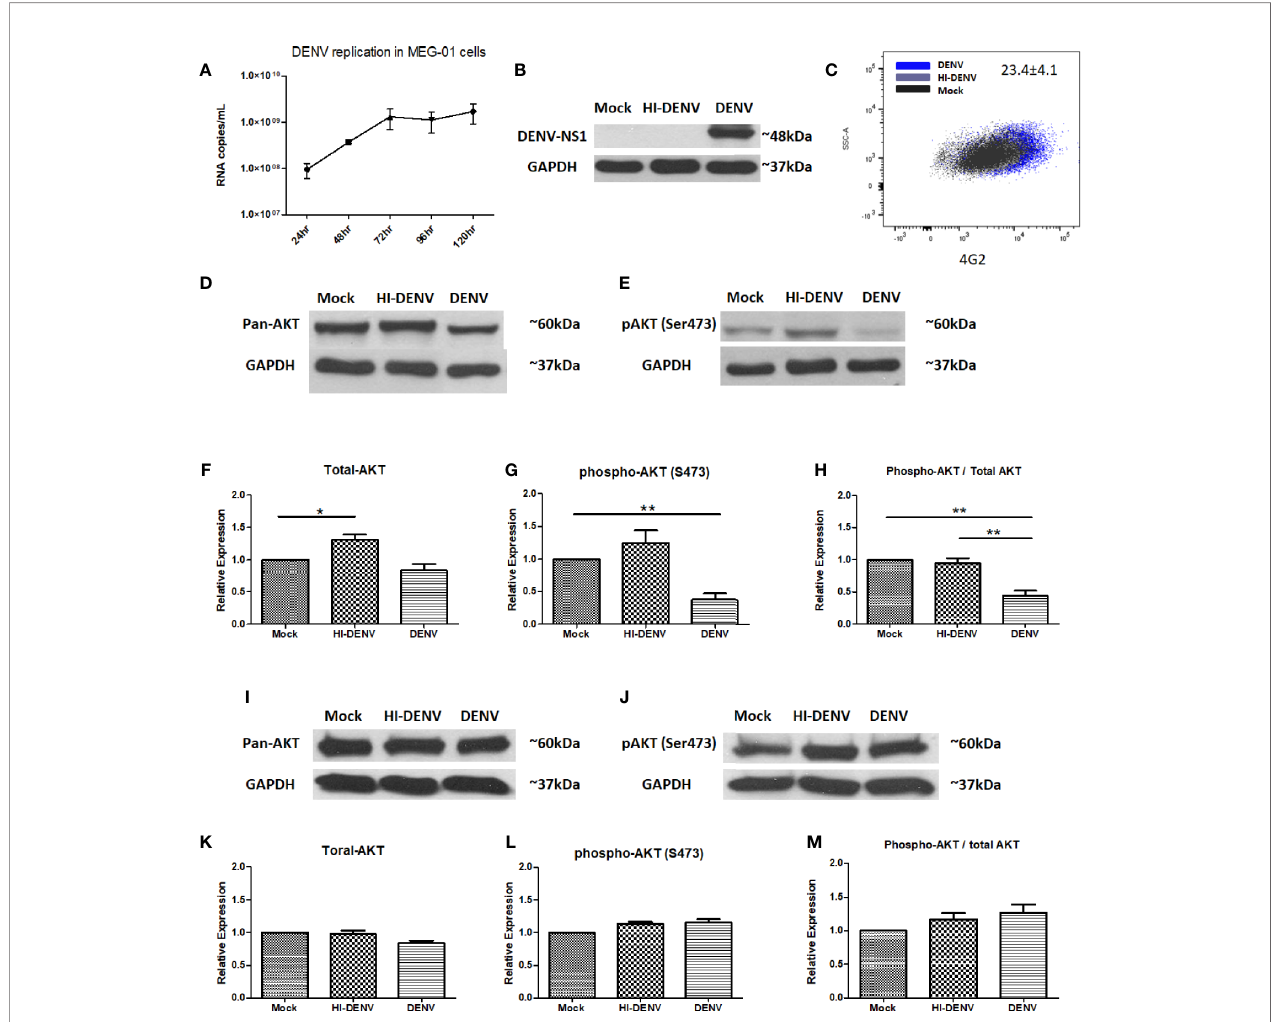
FIGURE 1 | DENV infects MEG-01 cells and modulates the expression of AKT. (A) MEG-01 cells were infected with 1 MOI of DENV, and replication was determined from cell culture supernatants collected at day 1 post-infection through day 5 post-infection by using RT-PCR. (B) Replication was further con fi rmed by immunoblotting for DENV NS1 (~48 kDa) in 5 th -day post infected cell lysate and (C) fl ow cytometric detection of DENV envelope protein using 4G2 antibody staining of infected cells (mean ± SE of infected cells = 23.4 ± 4.1). (D, E) Immunoblotting of pan-AKT and phosphorylated AKT (Ser473) in mock-infected, DENV inactivated virus treated, and DENV infected MEG-01 cell lysate at 5 th day post-infection. (F – H) Relative expression of pan-AKT and phospho-AKT was calculated by using the densitometry method and presented as column graphs. The ratio of phospho-AKT and pan-AKT is also presented as column graphs. (I, J) Immunoblot of pan-AKT and phospho-AKT from the lysate of mock, inactivated virus treated, and DENV infected HEK293 cells and (K – M) presentation of relative expression of pan-AKT and phospho-AKT as column graphs of mock control, inactivated virus treated, and DENV infected HEK293 cells. (*pValue < 0.05; **pValue <